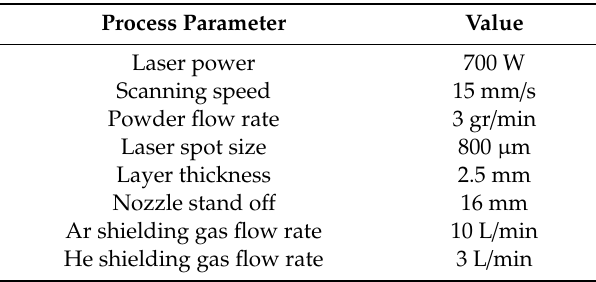
Table 1. Optimized process parameters for tracing a clearly defined, parallel borders, single line of Ti6Al4V with the least residual material.